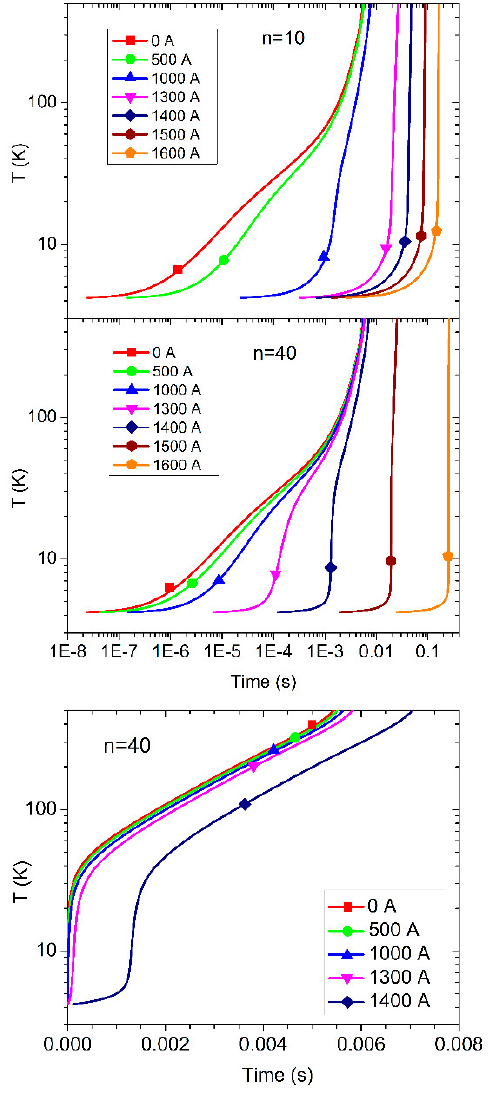
Figure 2. Top panel: results of the hot spot temperature simulations for two different n-values plotted in log–log scale. Bottom panel: selected curves for n = 40 plotted in the linear time scale.